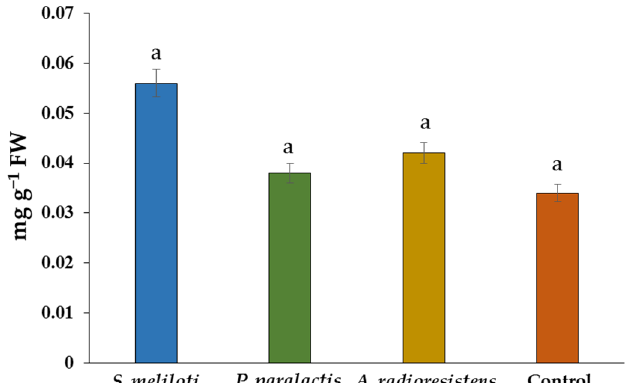
Figure 2. Effect of PGPR on total protein content in C. sativus fruit under greenhouse conditions. Data are shown as mean ± SD. Different letters indicate a significant difference ( p < 0.05) according to Tukey’s test.